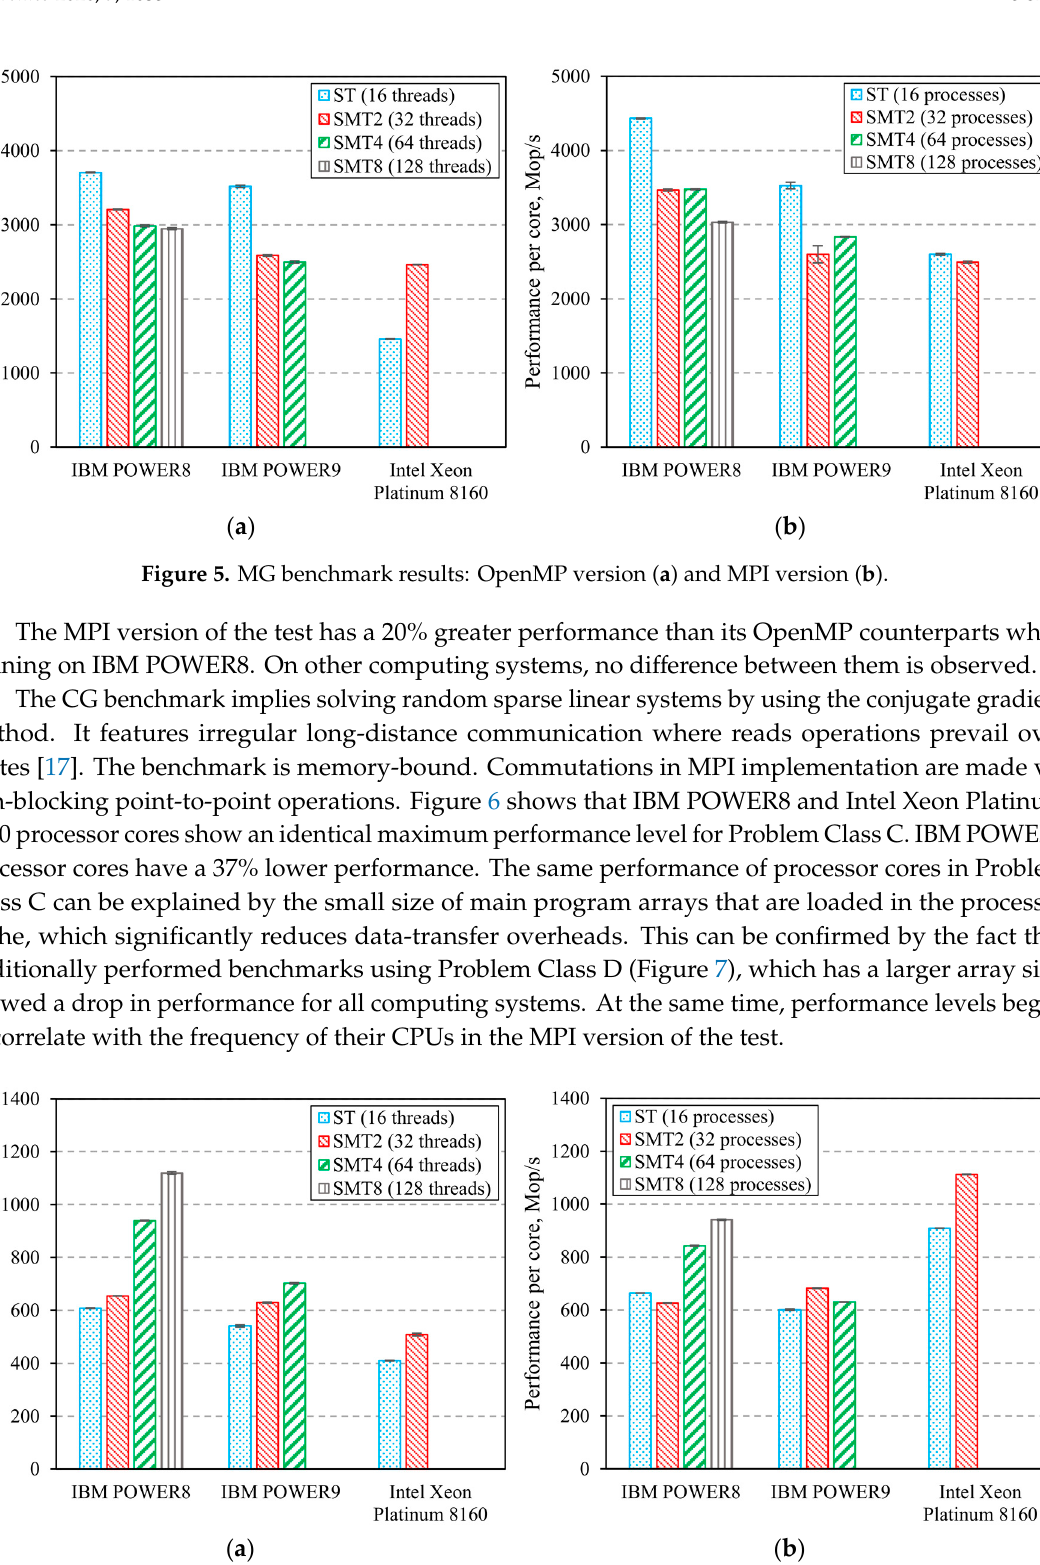
( b ) Figure 7. CG Class D benchmark results: OpenMP version ( a ) and MPI version ( b ). Note that increased performance is reached by adding threads up to the maximum permissible number for Class C of the CG benchmark. Problem Class D shows a reduced performance speedup with SMT technology. OpenMP and MPI technology are optimal parallel programming technologies for IBM processors in Problem Class C and Problem Class D of this benchmark, respectively, MPI technology is optimal for the Intel processor in Class C, and OpenMP is optimal for the same processor in Class D. The FT benchmark implies solving discrete 3D fast Fourier transform. It features high-rate long- distance communication [14]. Benchmark performance is limited by the memory-access speed. Collective communication in the MPI benchmark version was carried out by using the following collective operations: MPI_Reduce, MPI_Barrier, MPI_Bcast, and MPI_Alltoall. The results given in Figure 8 show that OpenMP technology boosts performance up to 48% when compared to MPI technology. However, using SMT technology does not lead to any significant performance improvements for IBM processors. Using the SMT2 mode improves performance by 14% for the Intel processor.